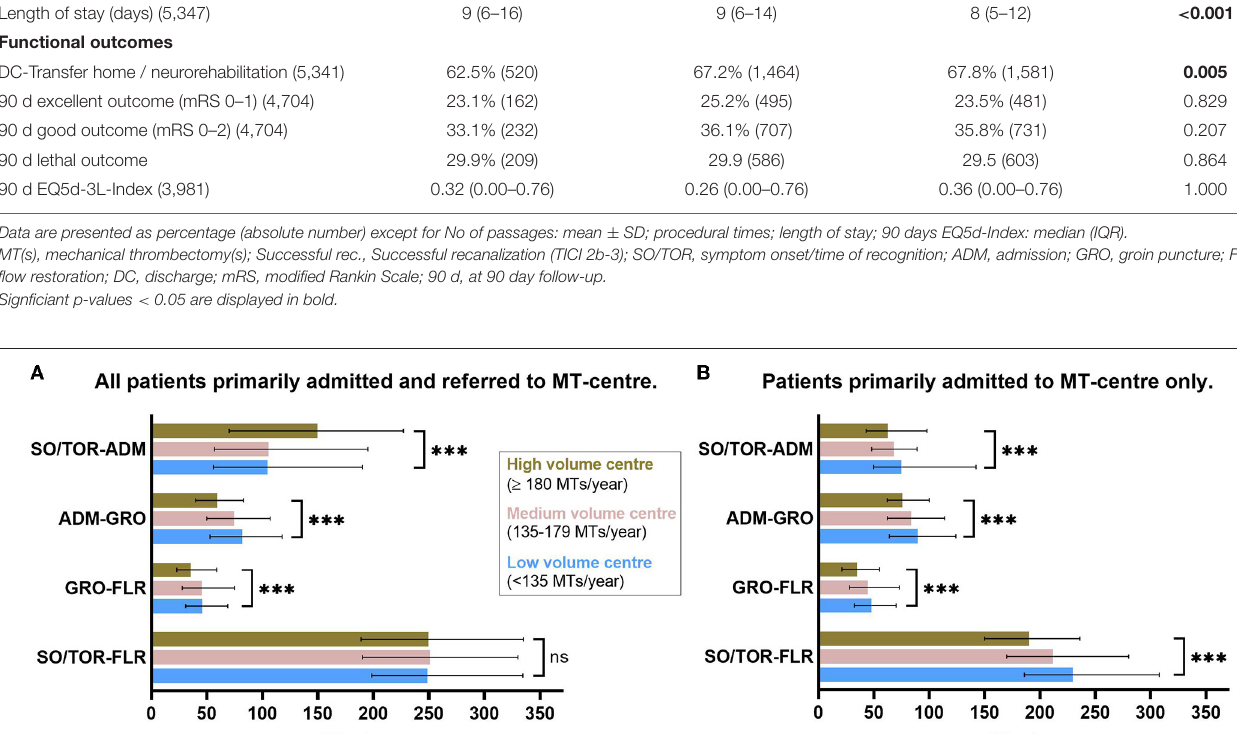
Medium volume center High volume center ( < 135 MTs/year) (135–179 MTs/year) ( ≥ 180